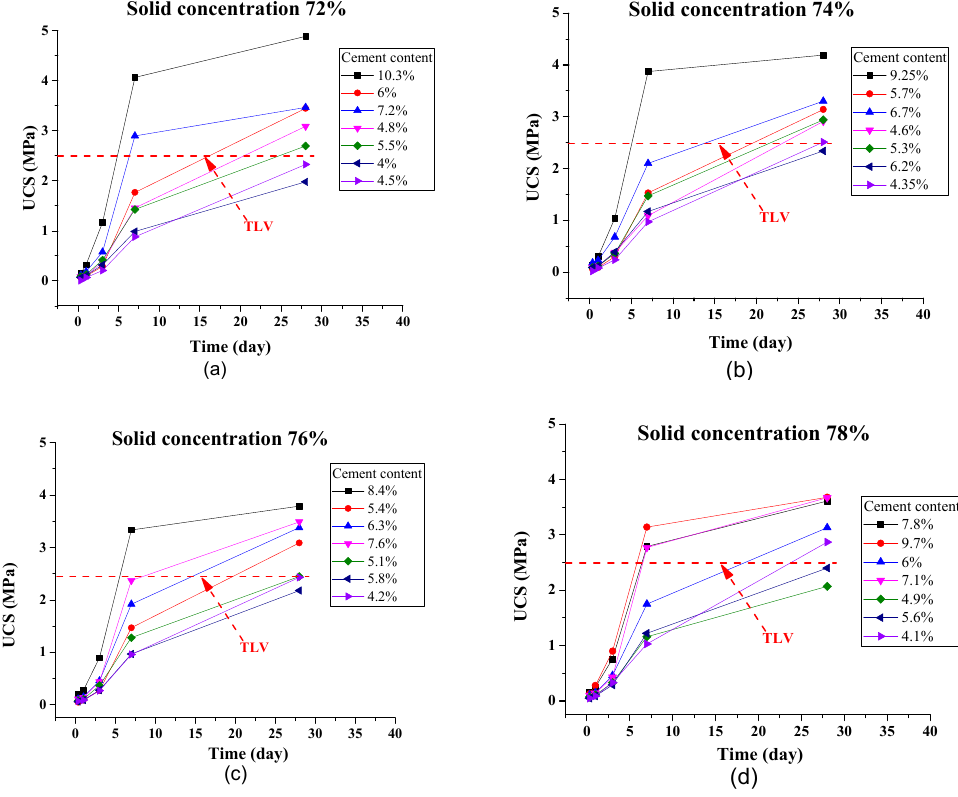
Figure 11. UCS of CPB after different curing times.